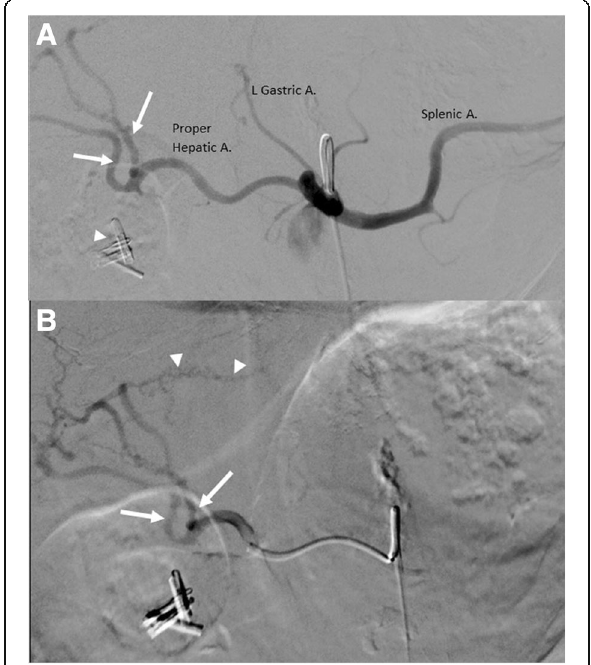
Fig. 1 a Celiac axis angiogram demonstrating right and left hepatic arteries (arrows) arising from a proper hepatic artery (PHA) with no branching GDA. No blood flow is seen towards site of bleeding as identified by endoscopic clips (arrowhead). b PHA angiographic subselection demonstrating right and left hepatic arteries (white arrows), with LHA distribution opacified (arrowheads)